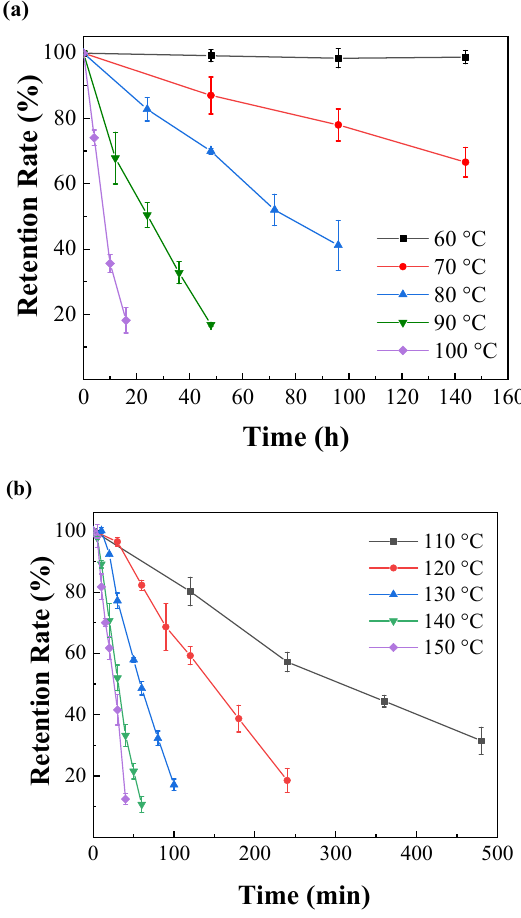
Figure 2. Thermal degradation of IPBC at different heating temperatures: ( a ) 60–100 ◦ C; ( b ) 110–150 ◦ C. Each point represents the average of three replicas per thermal